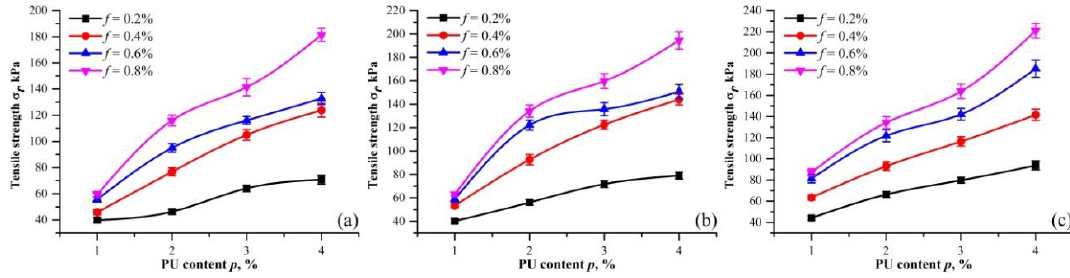
Figure 9. Tensile strength of specimens with different PU contents at different dry densities: ( a ) 1.40 g/cm 3 ; ( b ) 1.50 g/cm 3 ; and ( c ) 1.60 g/cm 3 ( t = 48 h, and the bars are standard deviations).